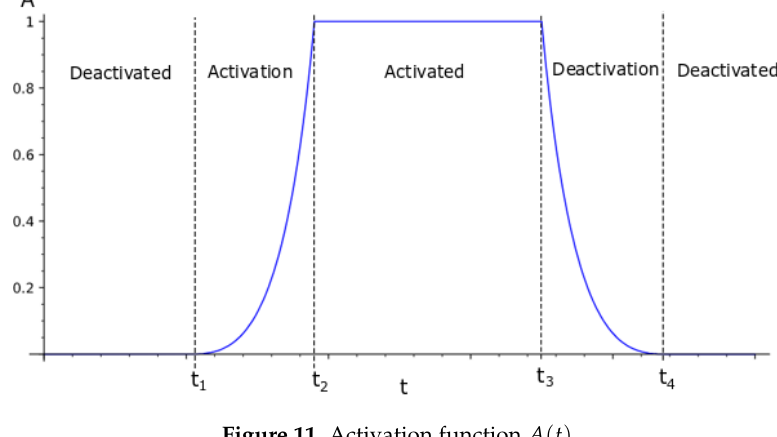
Figure 11. Activation function A ( t )